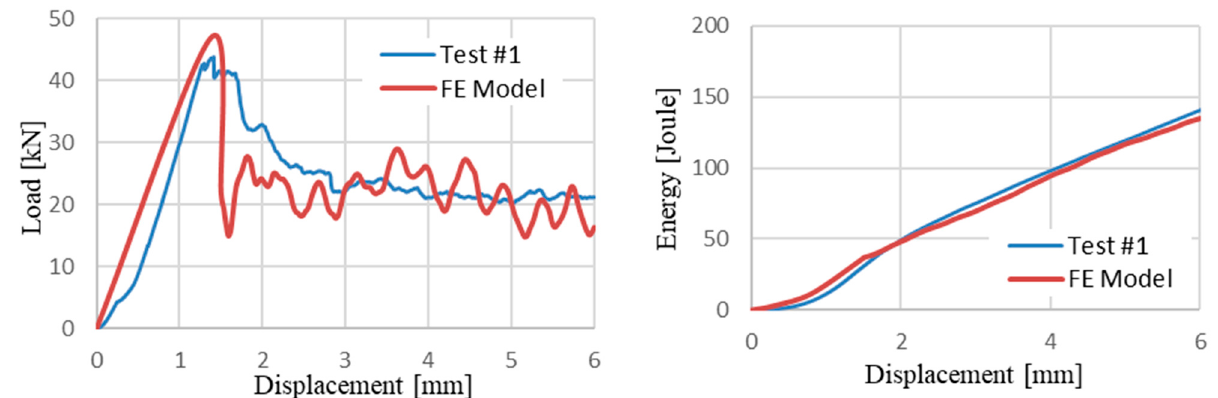
Figure 12. Comparison of the FE model of the sinusoidal specimen with 3 curvatures using experi- mental tests: load-displacement curves ( left ) and energy curves ( right ).